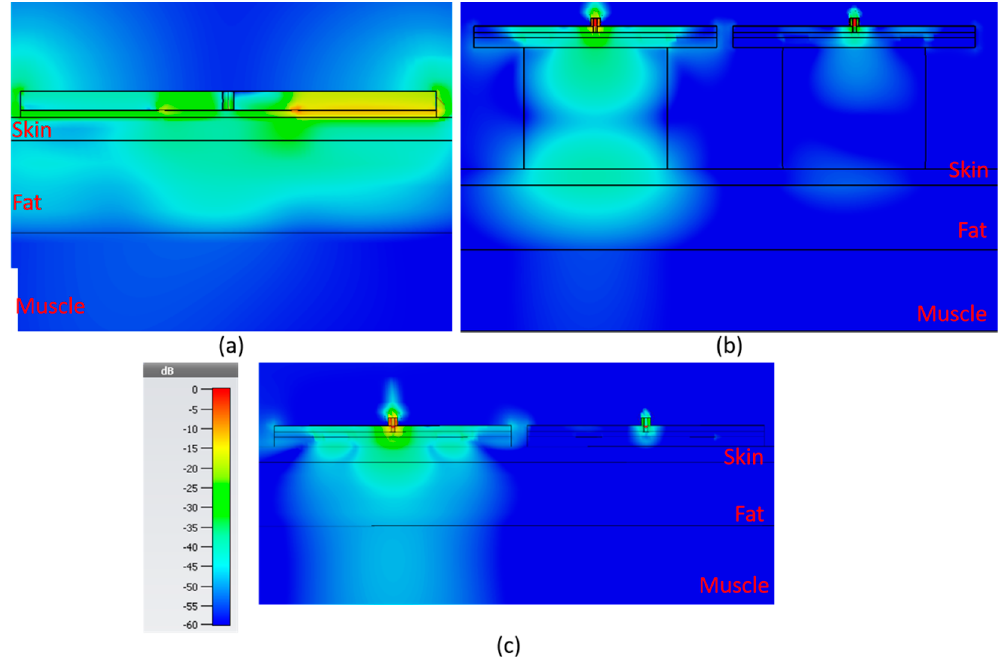
Figure 15. E-field for the 3 new sensors, 2 mm skin, 8 mm fat, 10 mm muscle ( a ) bandstop at 1.85 GHz, ( b ) SIW DR at 2.45